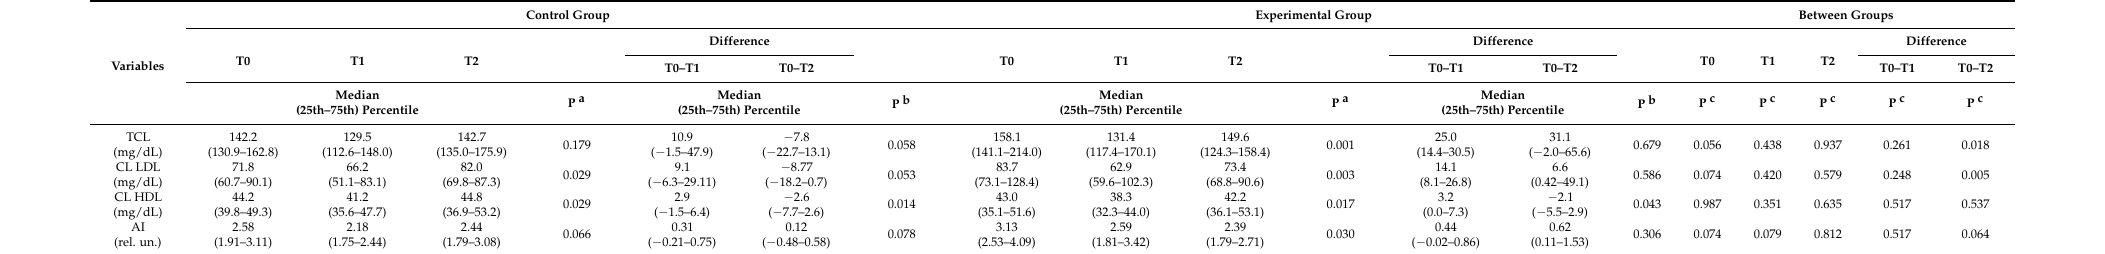
Table 4. Changes in patients’ serum cholesterol profiles during the trial, and comparison between